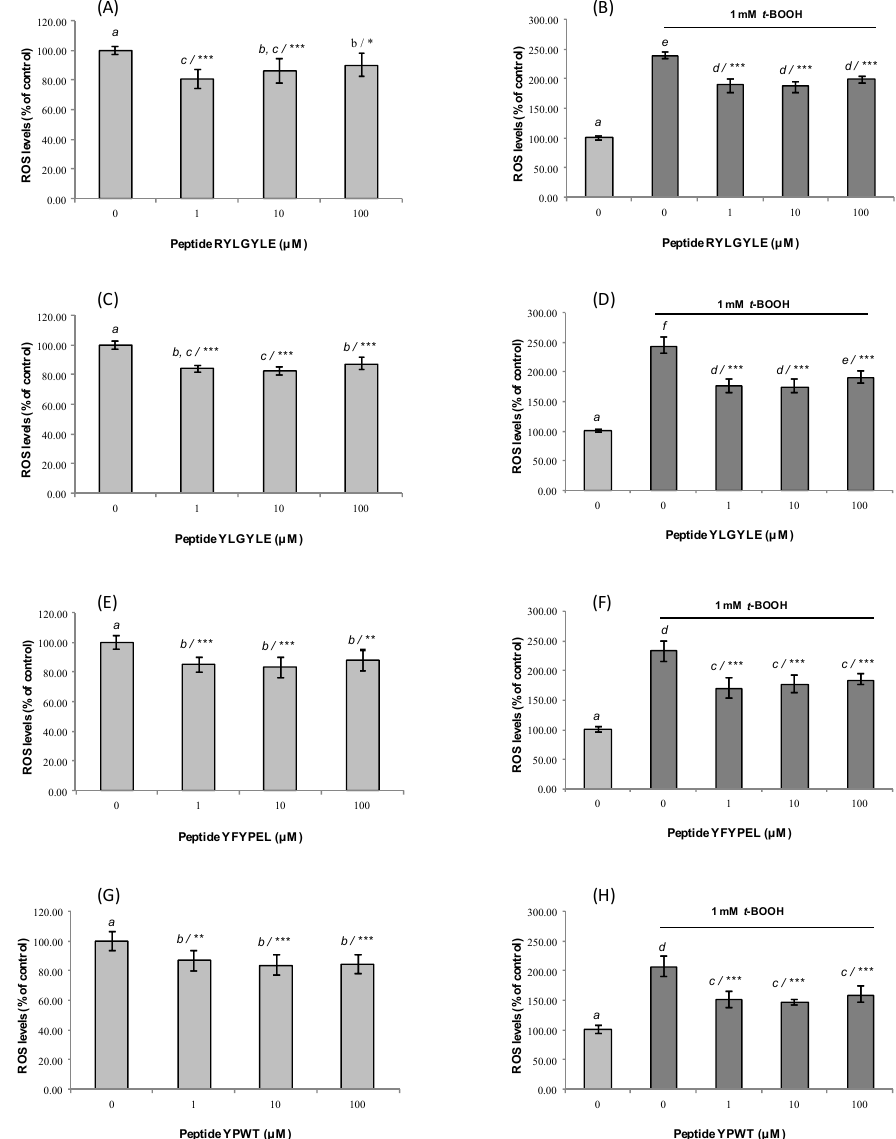
Figure 3. Dose-dependent effects of synthetic animal protein-derived peptides ( A , B ) RYLGYLE, ( C , D ) YLGYLE, ( E , F ) YFYPEL, and ( G , H ) YPWT on reactive oxygen species (ROS) production in non-stressed Caco-2 cells (A,C,E,F) and Caco-2 cells stressed with tert-butyl hydroperoxide ( t -BOOH, 1 mM). Cells were pre-treated with peptides at concentrations that ranged from 1 to 100 μ M for 24 h. Results were expressed as the percentage of ROS levels compared to control, which were considered as 100% (% control, mean ± standard deviation (SD), n = 3. Different letters indicate significant differences ( p < 0.05) and *** ( p < 0.001); ** ( p < 0.01); * ( p < 0.05) indicate significant differences of each concentration versus control under the same experimental conditions (one-way ANOVA followed by Tukey’s multiple comparison test).